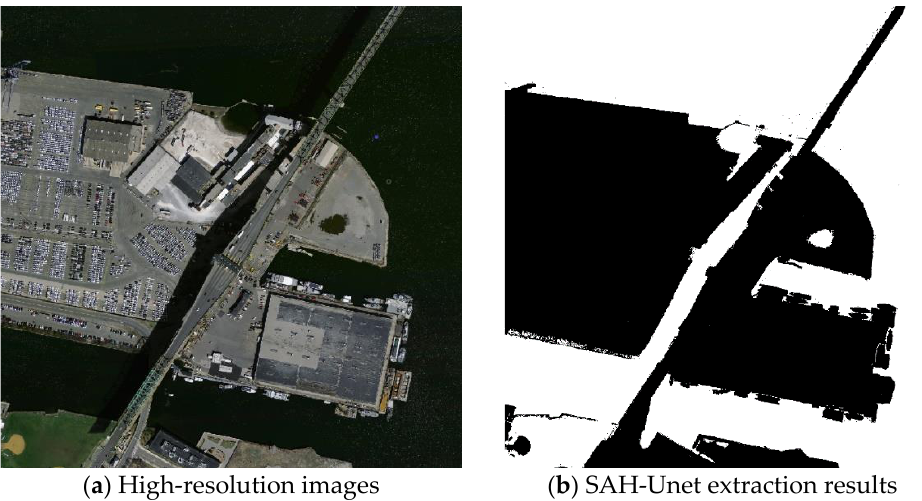
Figure 10. Test results based on high-resolution images from different times and regions.